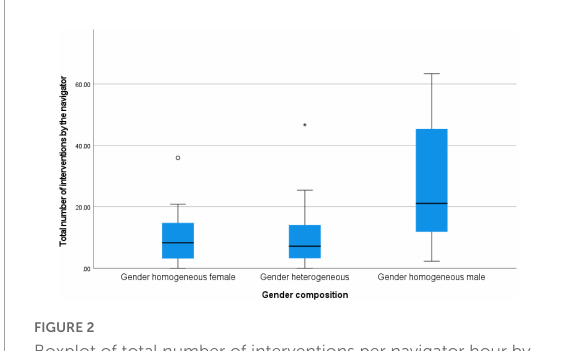
FIGURE2 Boxplot of total number of interventions per navigator hour by gender composition among students in Grades 7–9 ( n = 50). The * in the boxplot is a symbol for an extreme